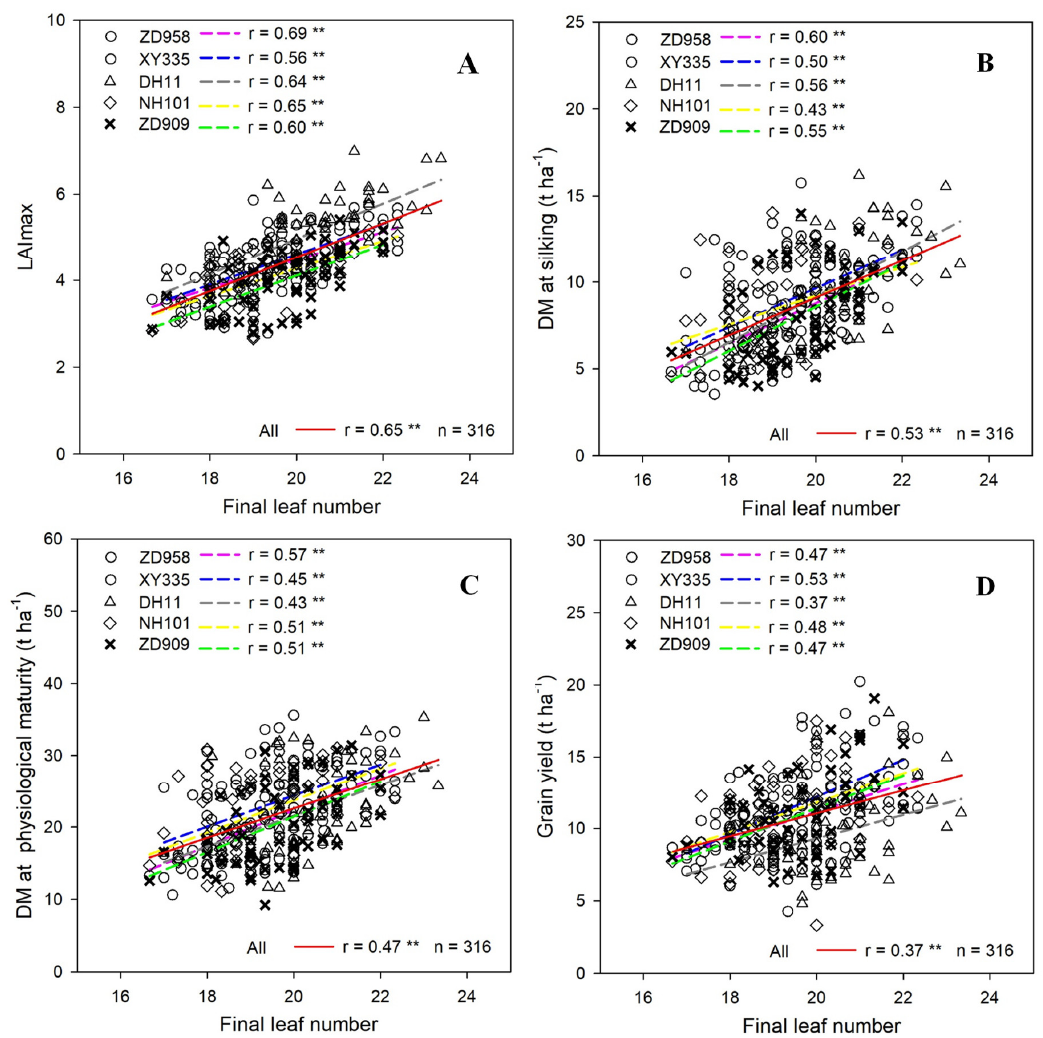
Figure 4. The relationships between the final leaf numbers and ( A ) the maximum leaf area index (LAImax), ( B ) the above-ground dry matter (DM) at silking, ( C ) the DM at physiological maturity, and ( D ) the grain yield for each cultivar across all locations. Markers with different shapes represent different cultivars. ** indicates that the correlation is significant at the p < 0.01 level.